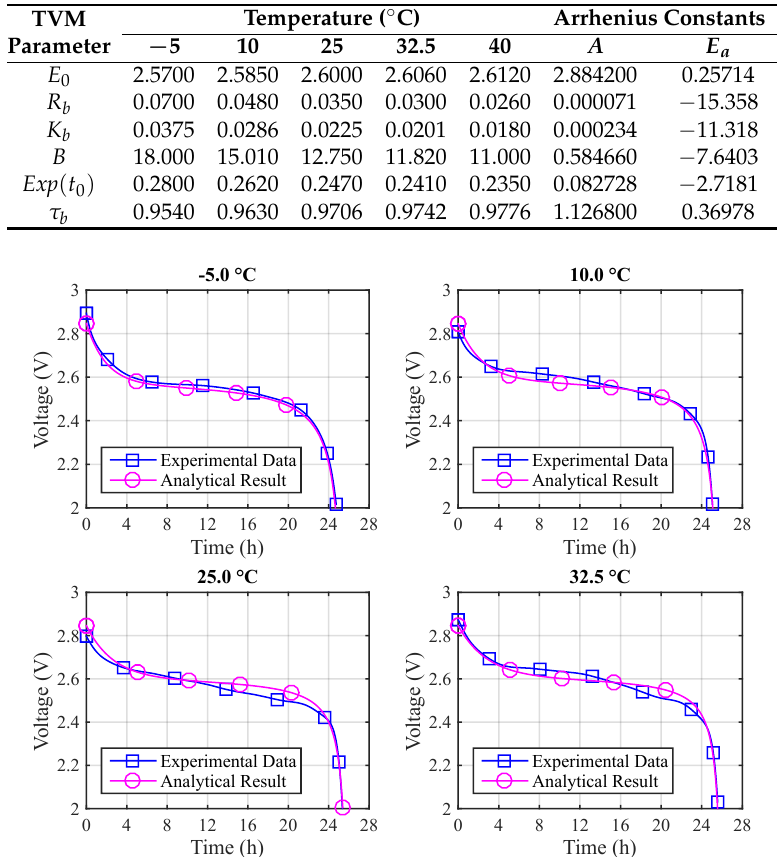
Figure 9. Experimental vs. T-KiBaM analytical results at different